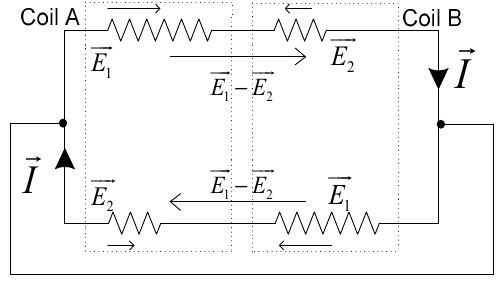
Figure 4. Starting Figure 4. Starting condition.